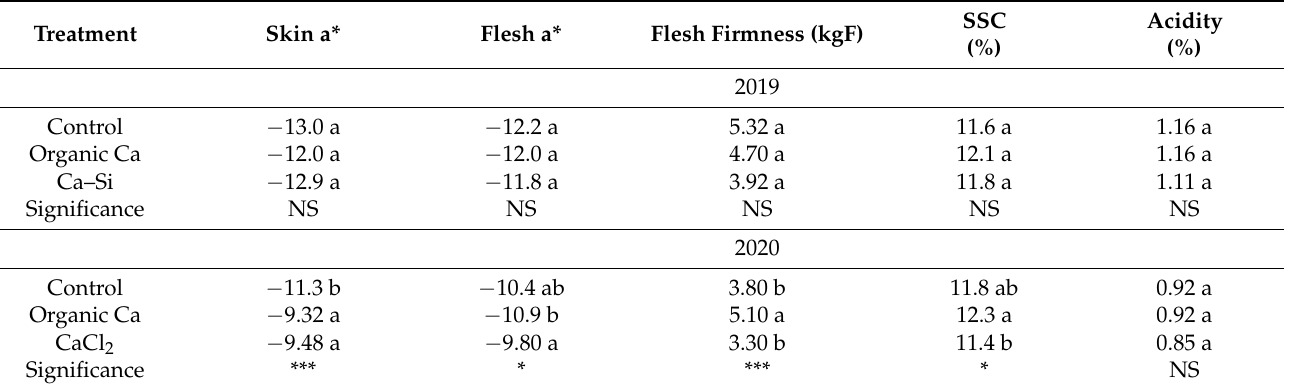
Table 1. The effect of calcium formulation application on the fruit quality at Kato Lehonia orchard. Ca–Si: calcium and silicon nanoparticles.